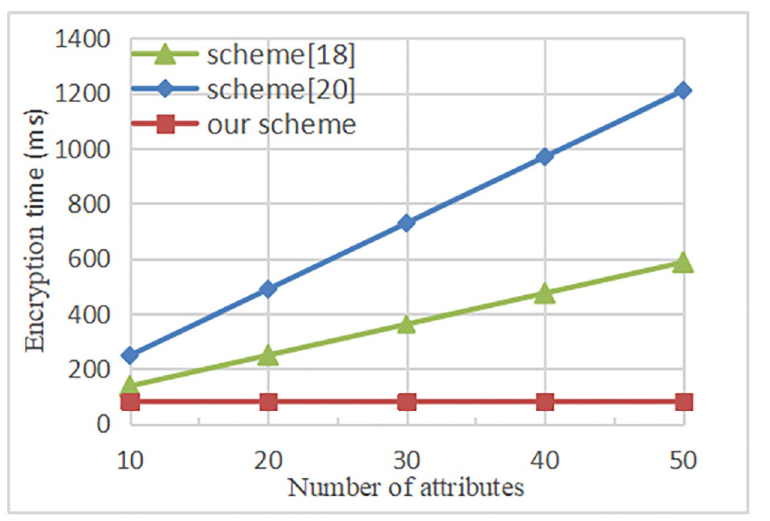
Fig 4. Time cost in